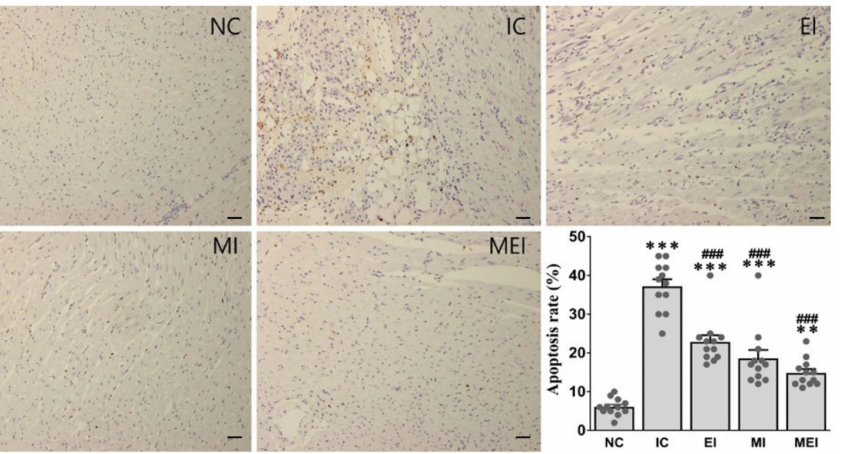
Figure 7. Effects of melatonin and exercise on cardiac apoptotic cell death in isoproterenol-challenged rats. Micrograph shows that TUNEL-positive cells were markedly increased in the IC group, whereas these are effectively inhibited by combined action of melatonin and exercise in the MEI group, indicating their anti-apoptotic effect ( n = 4 per group). ** p < 0.01 and *** p < 0.001 versus the NC group. ### p < 0.001 versus the IC group calculated through the Bonferroni post hoc test following one-way ANOVA. NC, normal control; IC, isoproterenol control group; EI, exercise plus isoproterenol- challenged group; MI, melatonin plus isoproterenol-challenged group; MEI, melatonin and exercise plus isoproterenol-challenged group. Scale bar, 100 µ